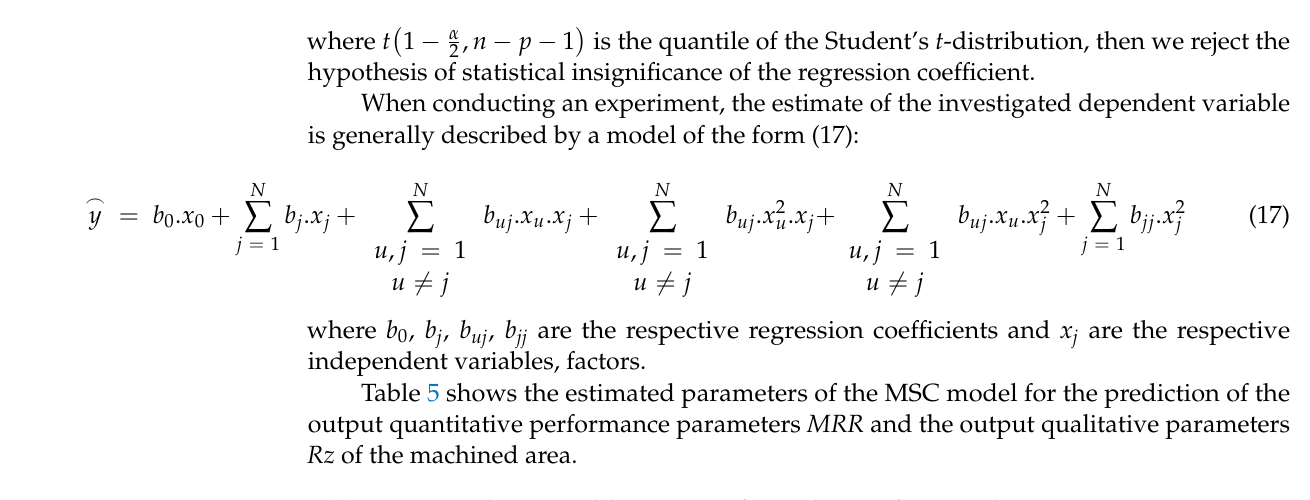
Table 5. Estimated MSC model parameters for prediction of MRR and Rz